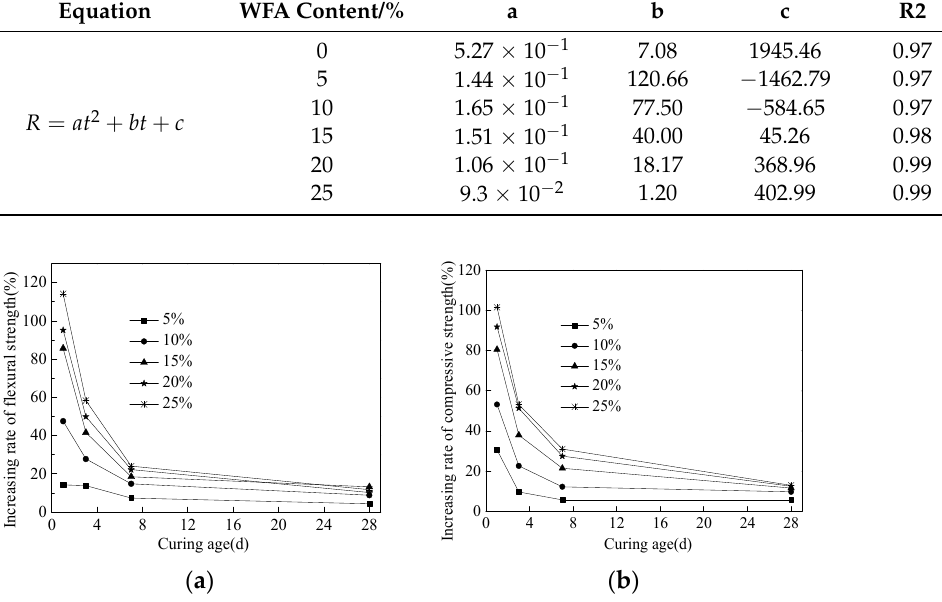
Figure 10. The increasing rate of mechanical strengths: ( a ) The increasing rate of flexural strength; ( b ) The increasing rate of compressive strength. Table 5. The fitting results of mechanical strength and mass ratio ( ω ) of WFA.